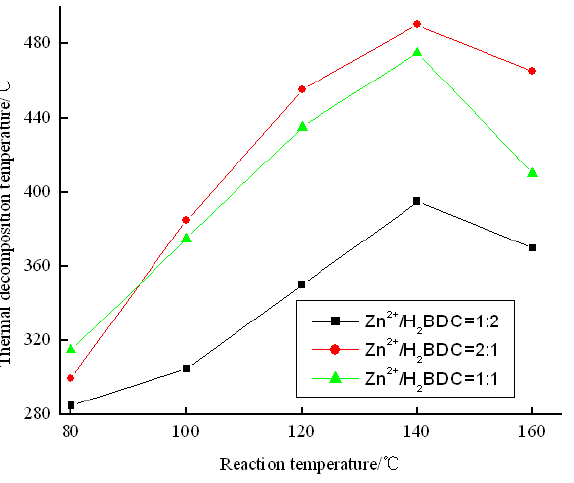
Figure 6: Effect of reaction temperature on the Nitrogen adsorption isotherms of the crystal